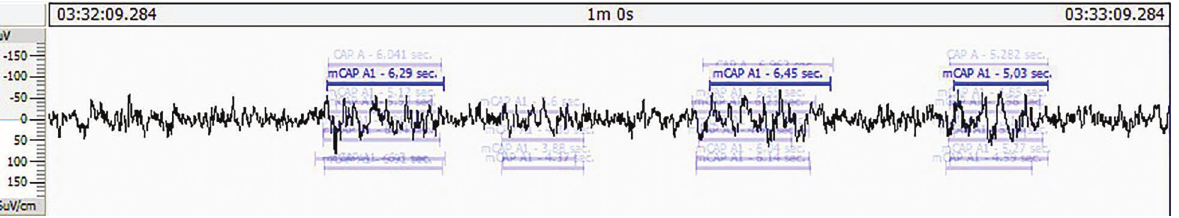
Figure 7. Sleep stage N3, one-minute epoch scorings. We found agreement between